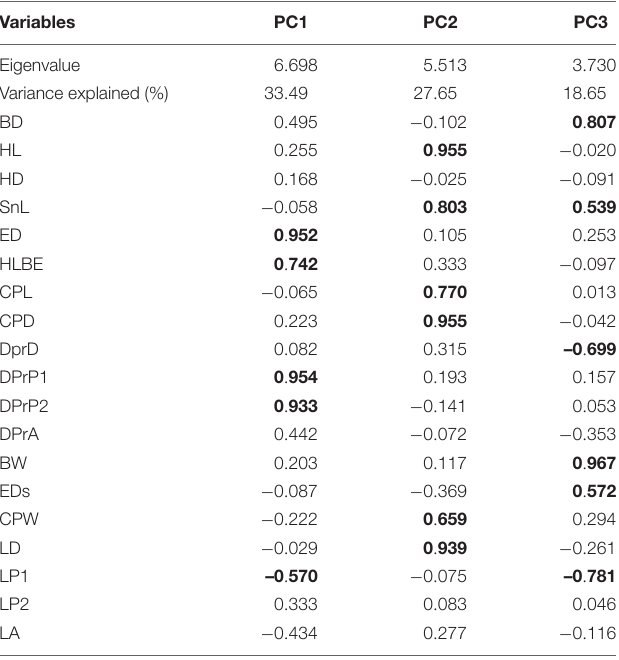
TABLE 2 | Principal component axis loadings of the morphometric characters in Hemiculter leucisculus across the six study sites in China.